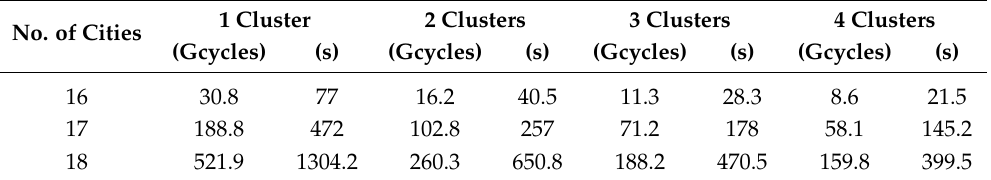
Table A1. Standard execution time for different configurations of TSP on the